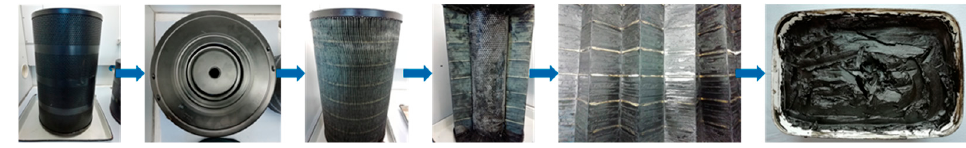
Figure 4. Flow sheet of dismantling, extraction of waste debris/sludge, example for SE_01. After filtration, the particles were washed again in acetone and/or isopropanol and finally dried in an oven overnight at 80 °C. As a side effect of the filtration processes,